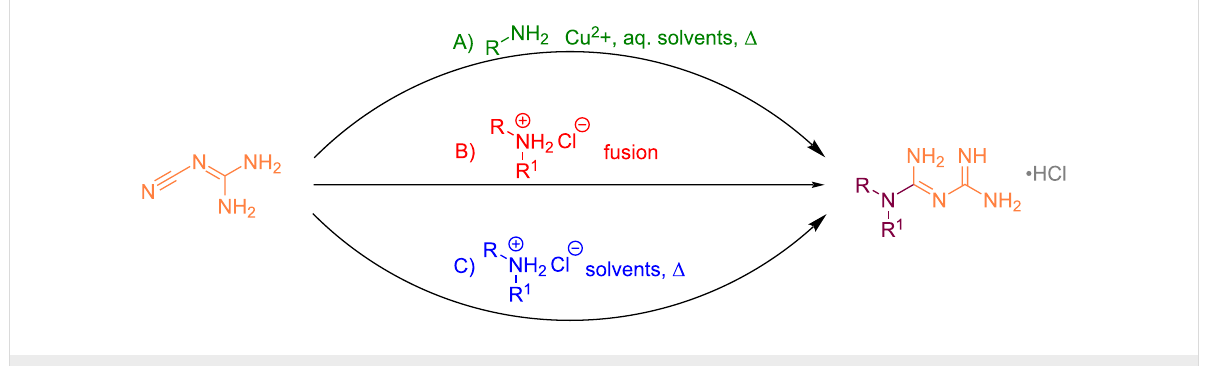
Scheme 1: The three main preparations of biguanides from cyanoguanidine.